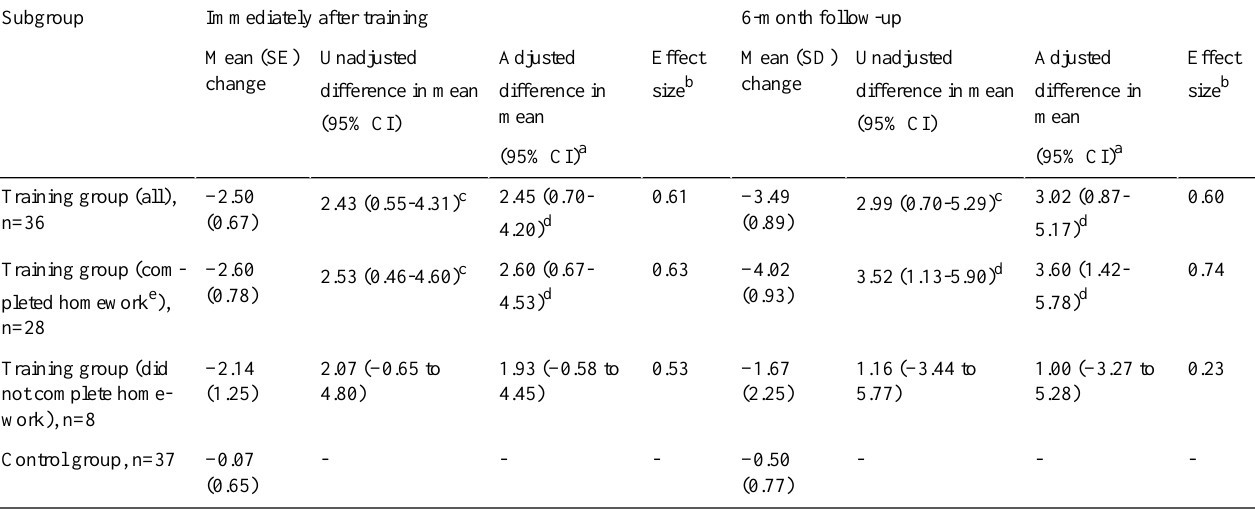
Table 3. Subanalyses of K6 score among participants with K6 ≥ 5 at